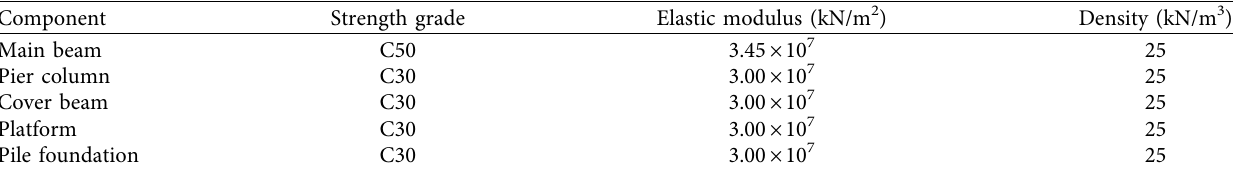
Table 1: Material parameters of the bridge structure.